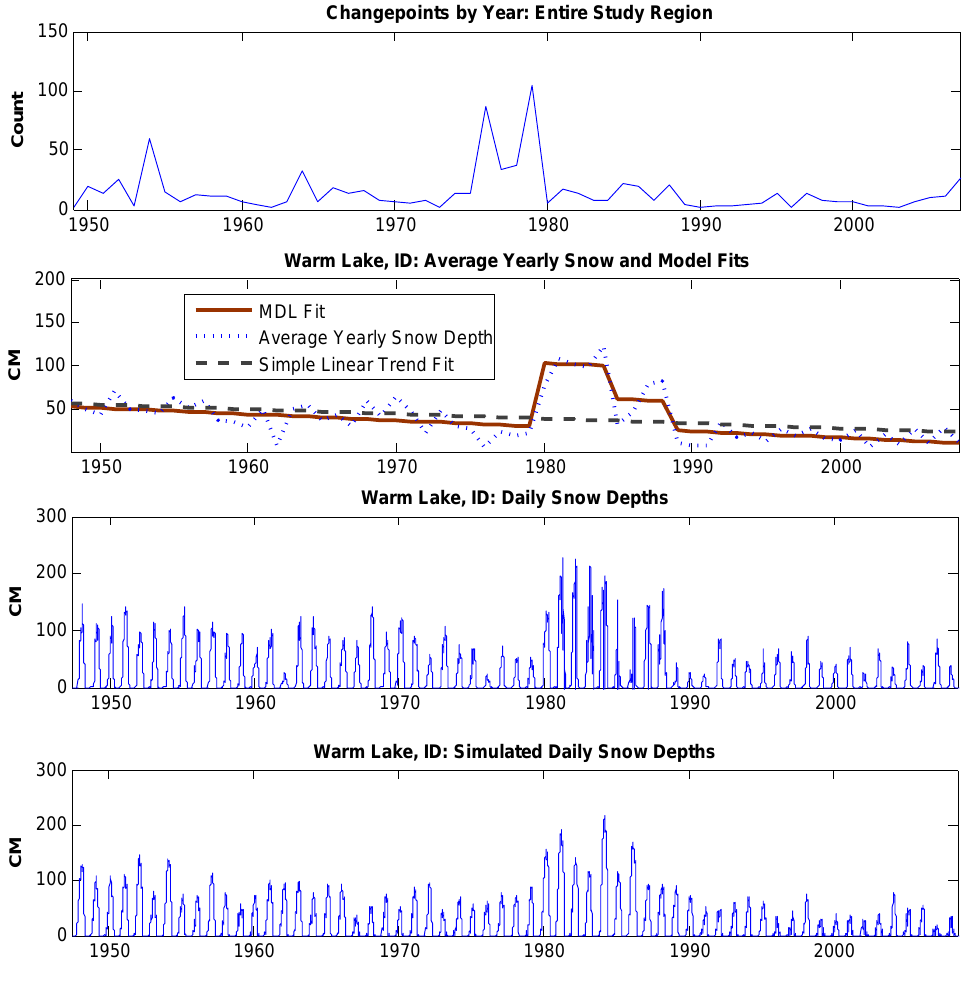
Figure 2. Top graph: changepoints found by year over all grids. Second graph from top: the model’s estimated mean for the daily snow depths at the Warm Lake, Idaho grid, visually demonstrating the effects of a negative trend and the three changepoints. Seasonal effects are not included for visual clarity. second graph from bottom: The Warm Lake, Idaho observed snow depths. Bottom graph: a simulated realization of the Warm Lake, Idaho snow depths from the fitted model. This simulation includes the three